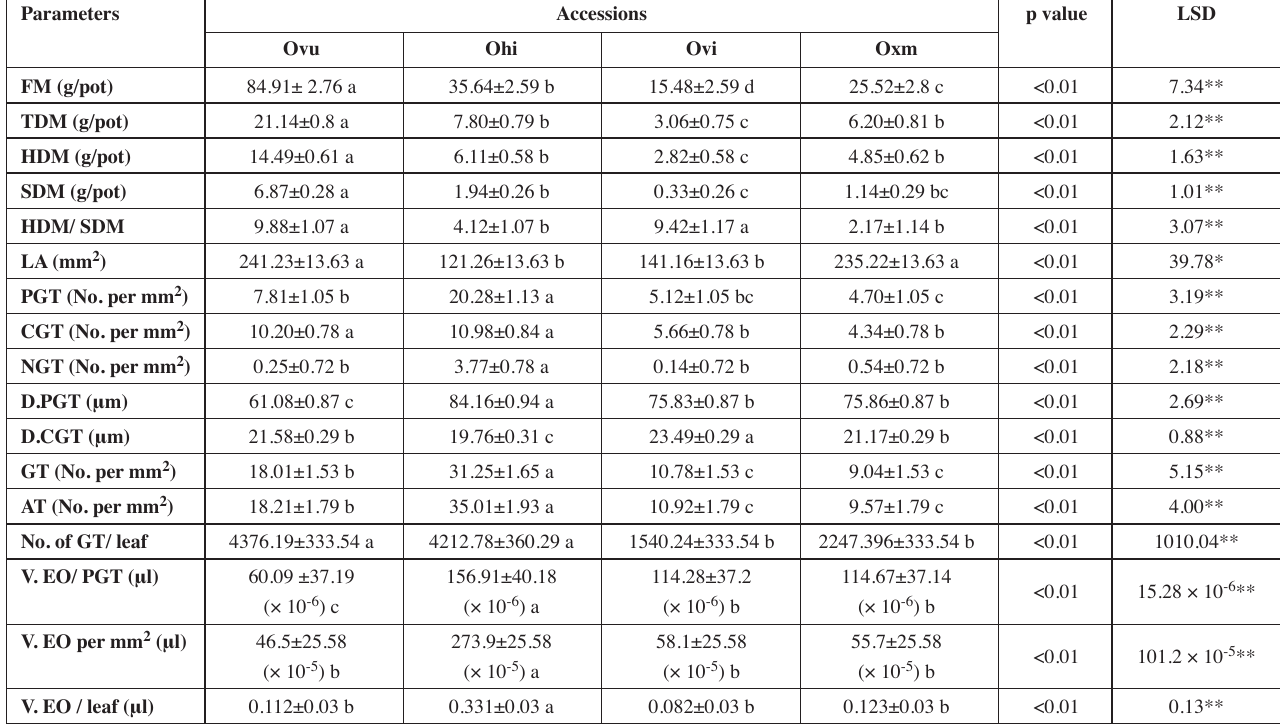
Tab. 2: Mean values (± standard error) of evaluated parameters of four Origanum vulgare accessions (Ovu: Origanum vulgare L. ssp. vulgare , Ohi: Origanum vulgare L. ssp. hirtum (Link) letswaart, Ovi: Origanum vulgare L. ssp. viride (Boiss.) Hayek, Oxm: Origanum vulgare L. ssp. viride (Boiss.) Hayek × O. majorana